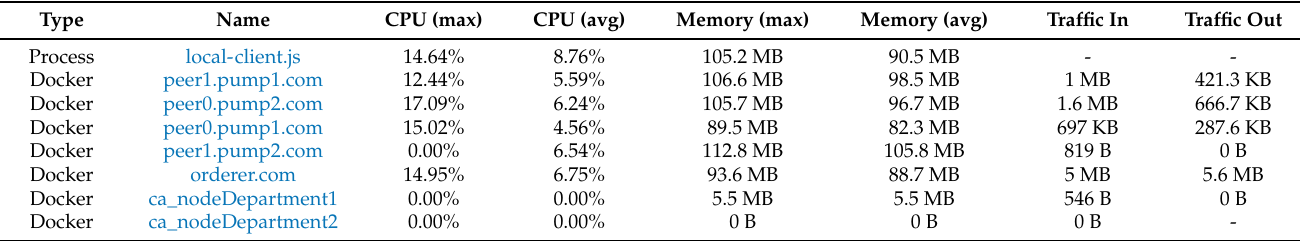
Figure 16. Latency in query transaction. Table 5. Resource utilization analysis of the proposed